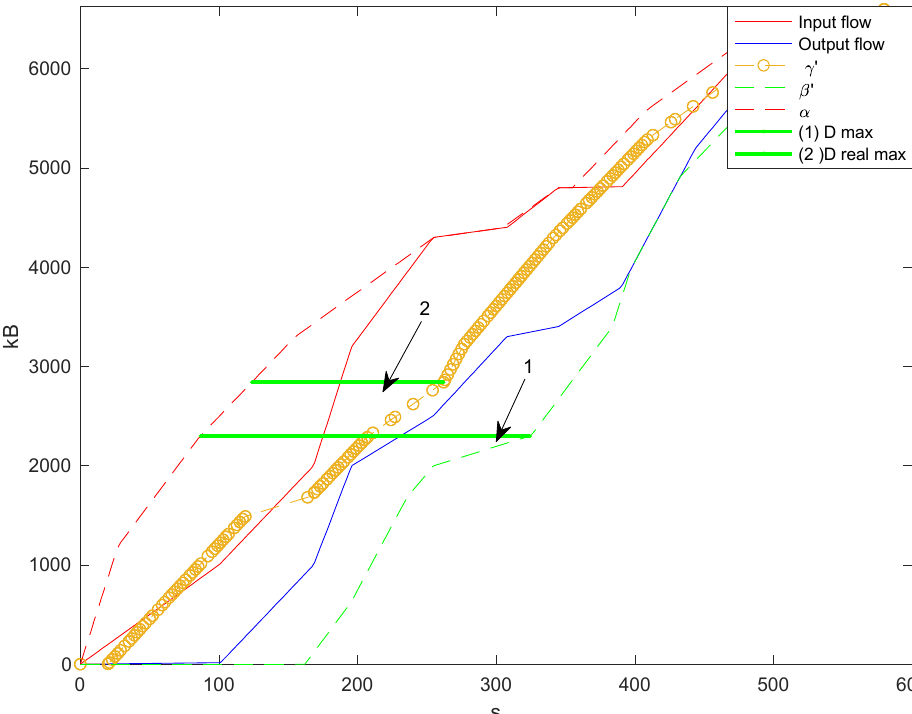
Figure 7. Experimental Network Calculus curves for a quasi-normal distributed sample with µ = 500, σ = 100; size of L = 10. Arrow 1 points to the maximum delay for the service curve (7), arrow 2 points to the maximum delay estimation for the service curve (11).